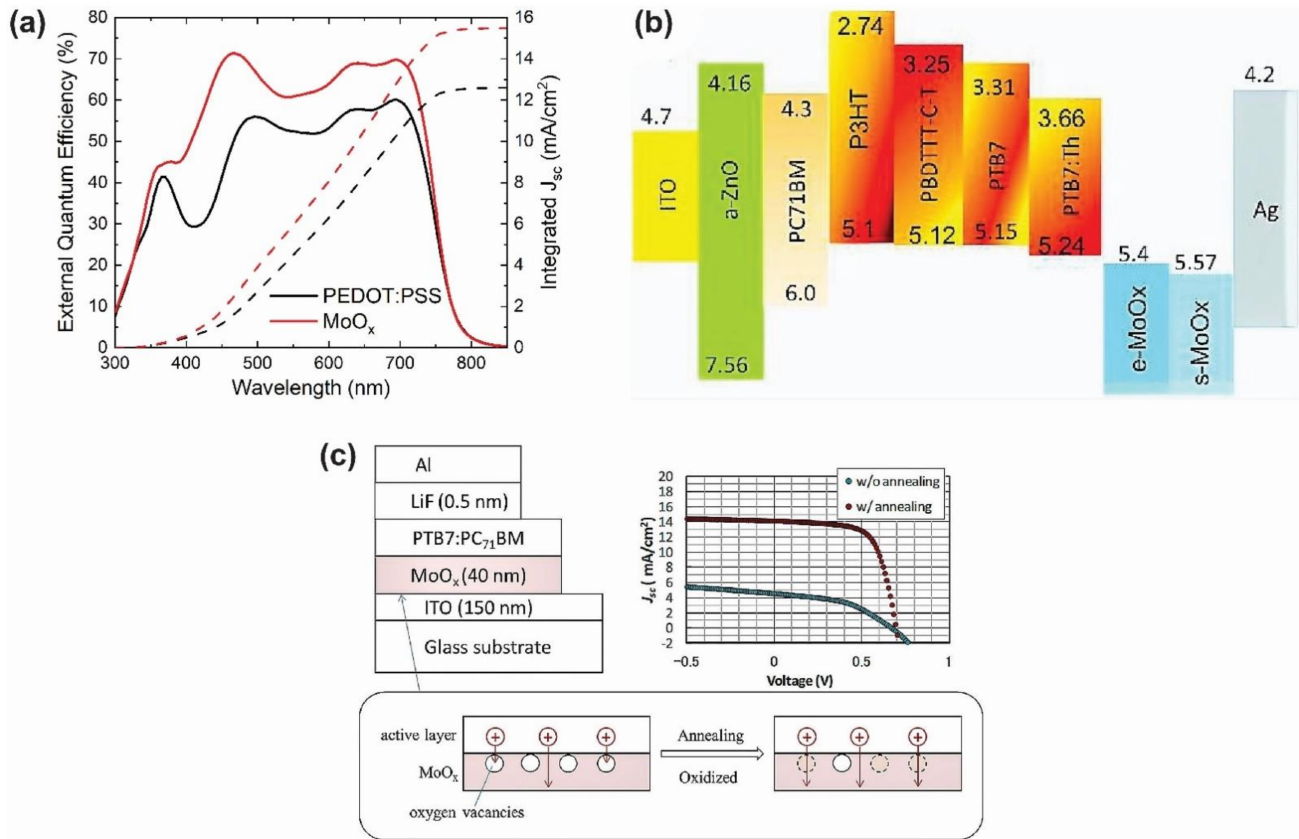
Figure 3. ( a ) External quantum efficiency of inverted OSCs with MoO 3 and PEDOT:PSS HTLs. Adapted with permission from [98]. ( b ) Energy level diagram of inverted OSCs with different donor polymers. Adapted with permission from [99]. Copyright 2016, Elsevier. ( c ) Reduction of oxygen vacancies by annealing treatment. Adapted with permission from [103]. Copyright 2016,